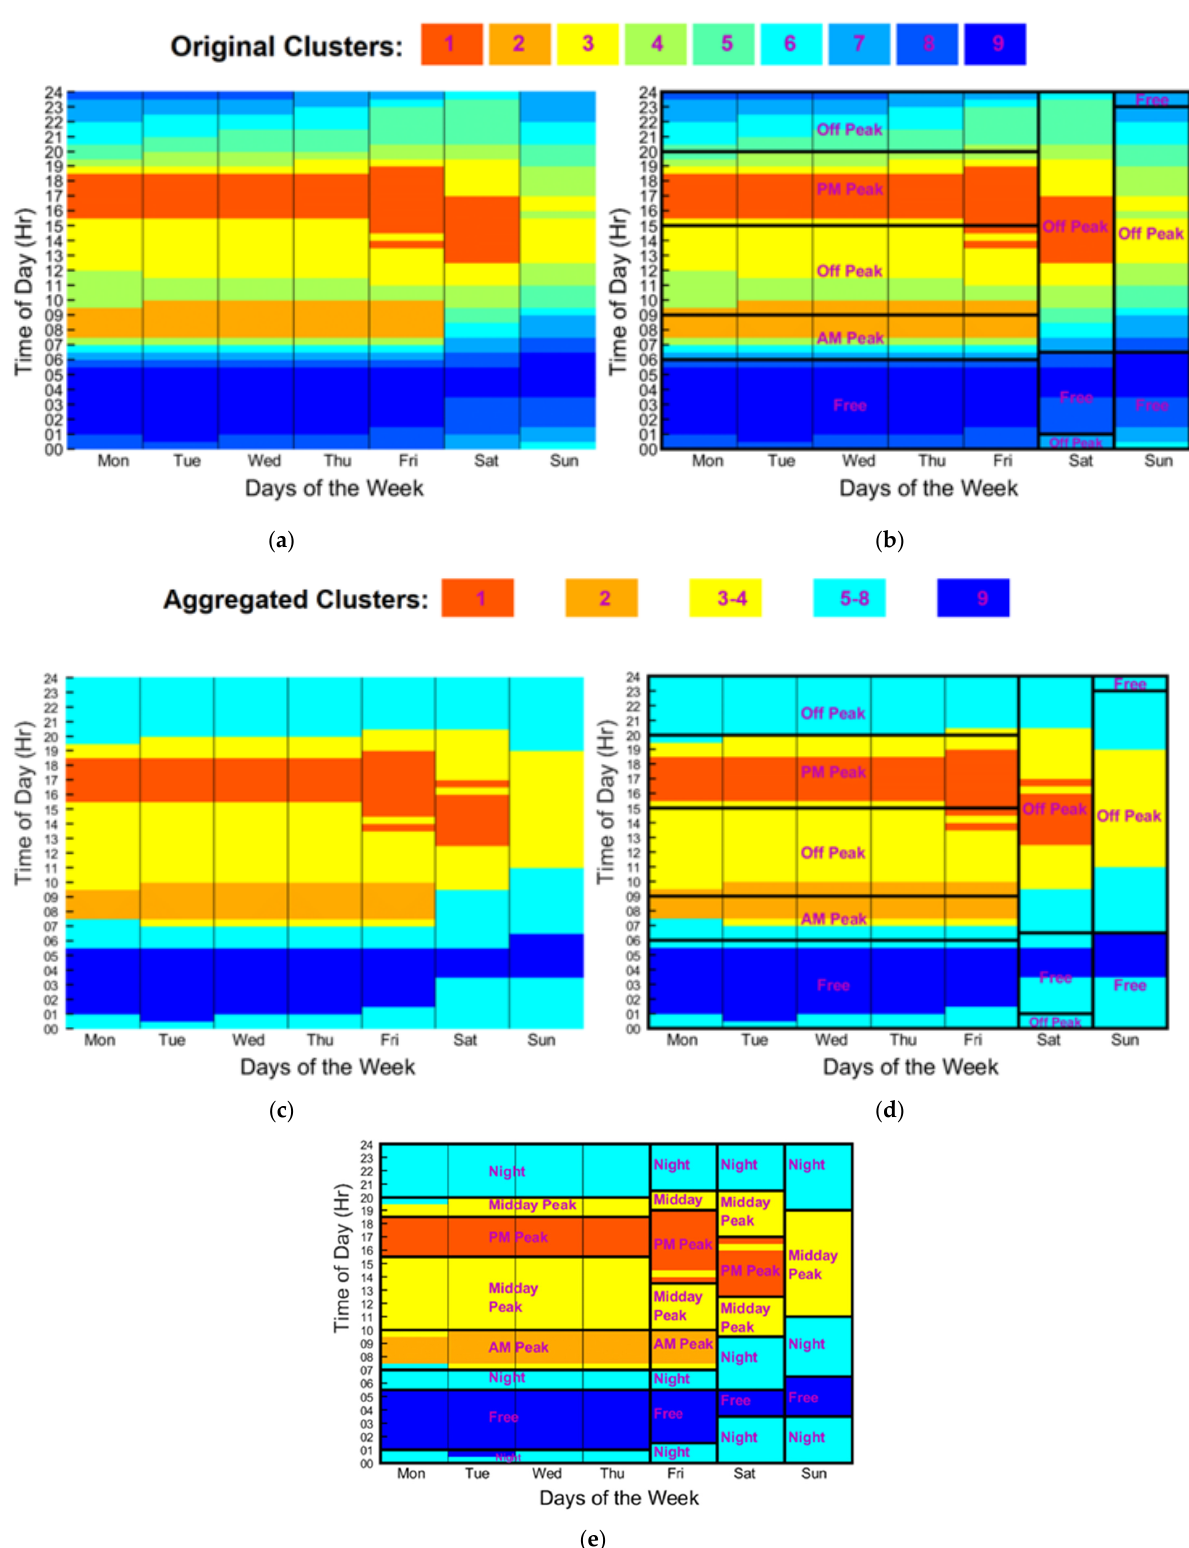
Figure 8. Spatial characteristics of projected volume profiles; ( a ) dominant cluster throughout the week; ( b ) aligning with current TOD schedule; ( c ) aggregated clusters throughout the week; ( d ) aligning with current TOD schedule; ( e ) proposed TOD schedule. Note: Monday (Mon), Tuesday (Tue), Wednesday (Wed), Thursday (Thu), Friday (Fri), Saturday (Sat), Sunday